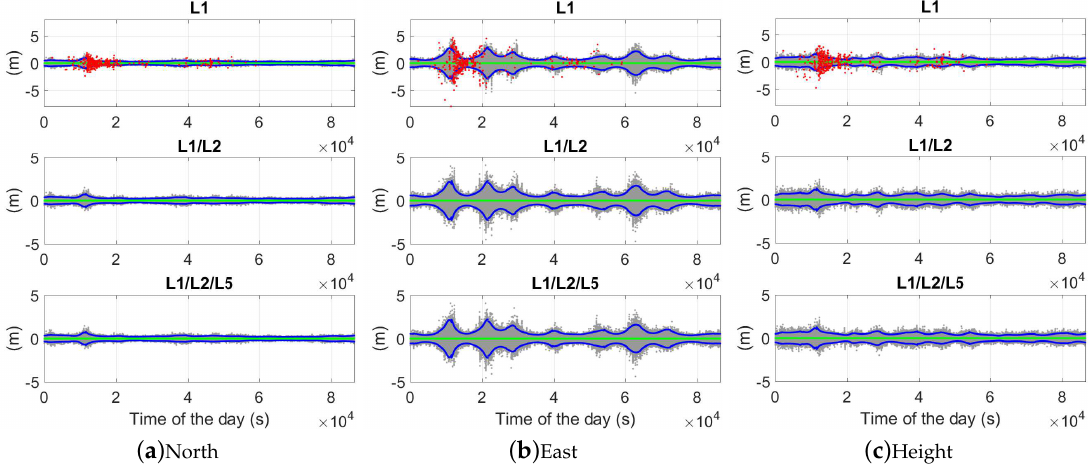
Figure 11. Baseline errors for CUAA-CUBB in the phase-only two-epoch case. The time span between the two epochs is 60 s. The gray, green, and red dots represent the ambiguity-float, -correctly-fixed, and -wrongly-fixed solutions, and the blue dots represent the 95% formal confidence intervals of the ambiguity-float solutions. Note that the scales in different sub-figures are